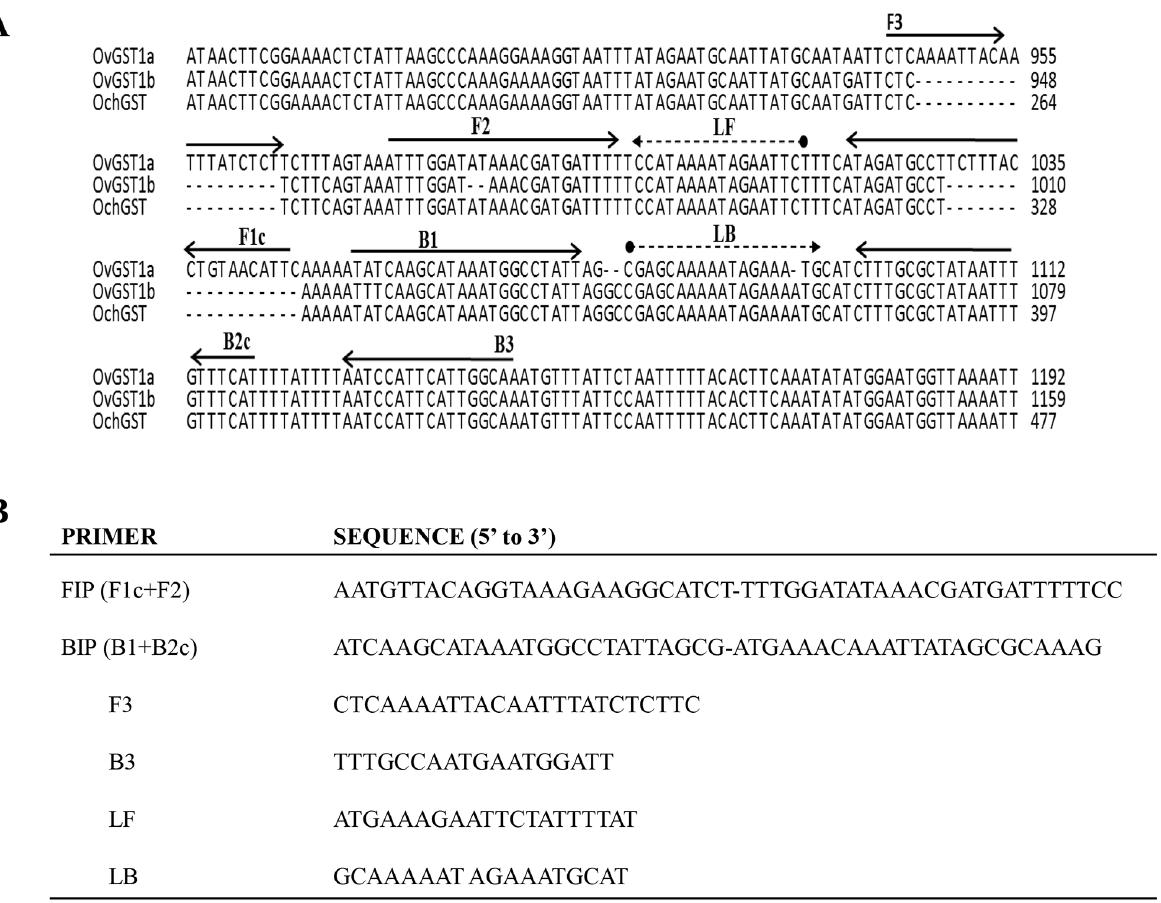
Figure 3. Alignment of partial gene sequences of glutathione S -transferases (GSTs) from O.volvulus ( OvGST1a , OvGST1b ) and O. ochengi(OoGST1) (A) and primer sets targeting OvGST1a (B). Primers are indicated by solid black arrows and dash arrows represent the binding regions of the loop forward (LFP) and loop back (LBP) primers respectively.